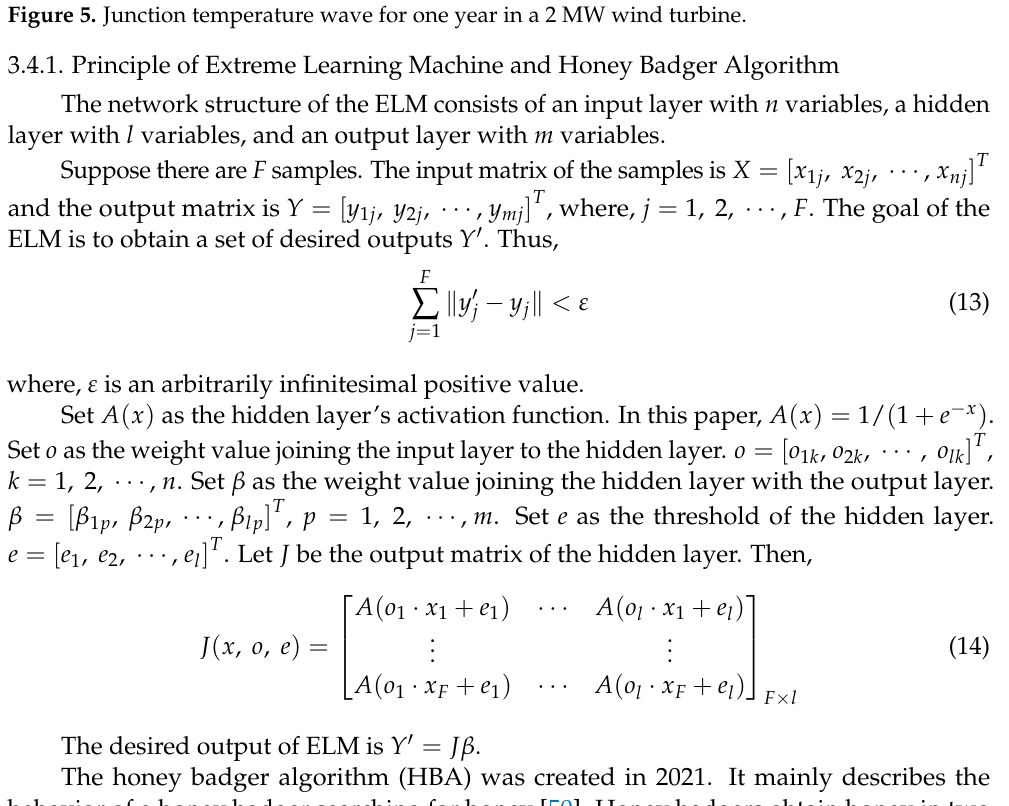
Figure 5. Junction temperature wave for one year in a 2 MW wind turbine.